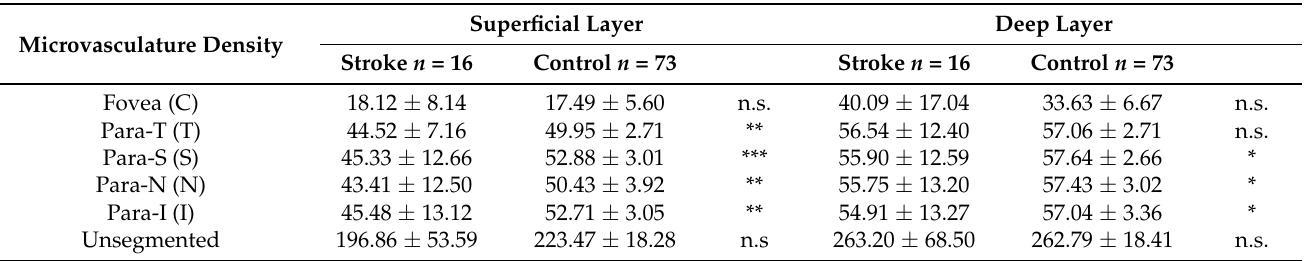
Table 3. Comparison of mean ± SD microvasculature density in stroke and control groups. n is the number of subjects in that group (stroke or control) on which the mean vasculature density was calculated. Statistical significance of the difference between variables computed with the